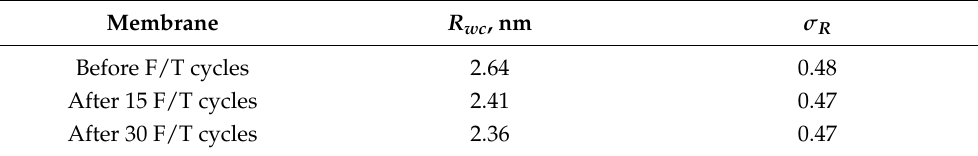
Table 3. The size of water-swollen Nafion ® 212 ionic domains before and after F/T cycles.